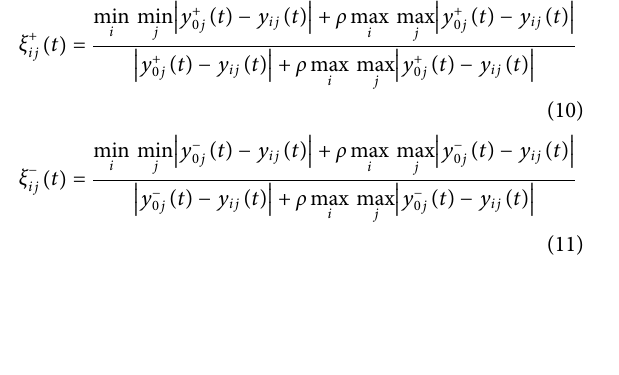
Where G + ( t ) and G − ( t ) respectively represent positive ideal weighted gray correlation coef fi cient matrix and negative ideal weighted gray correlation coef fi cient matrix. Generally, the feasible scheme is denoted as z i ( t ) , the ideal scheme as z p i ( t ) and the row vector is denoted